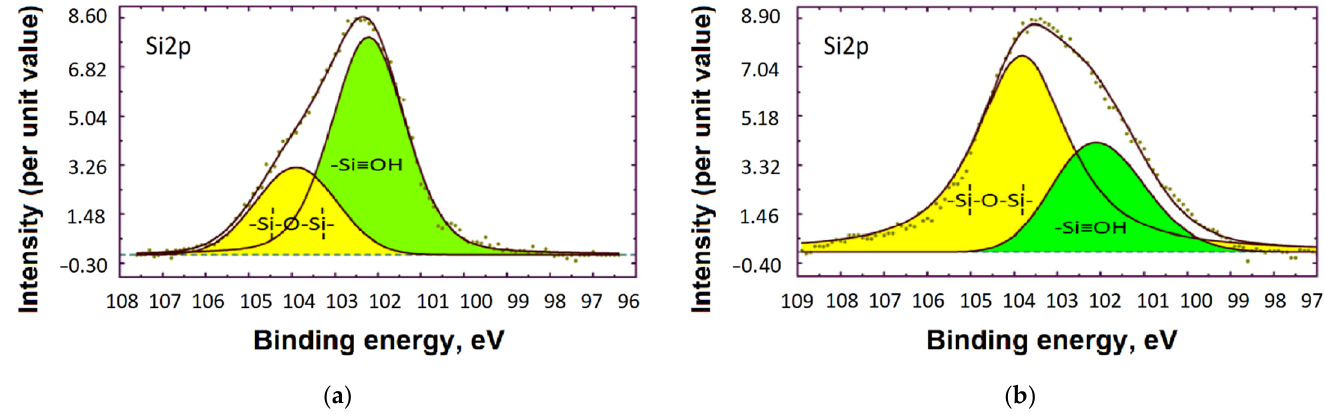
Figure 6. Si2p spectra of samples with various immersion times in a hydrophobic inhibitor solution: ( a ) 10 min; ( b ) 60 min.